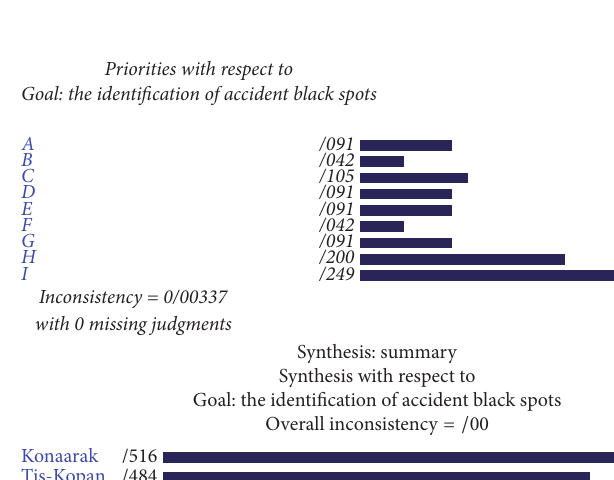
Figure 8: Section 7: Dashtyari-Konaarak.